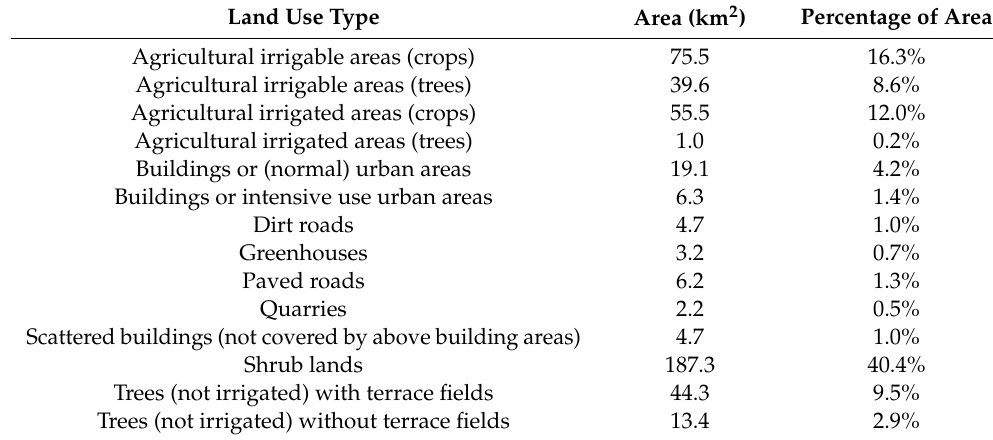
Table 1. The land use classes in the study